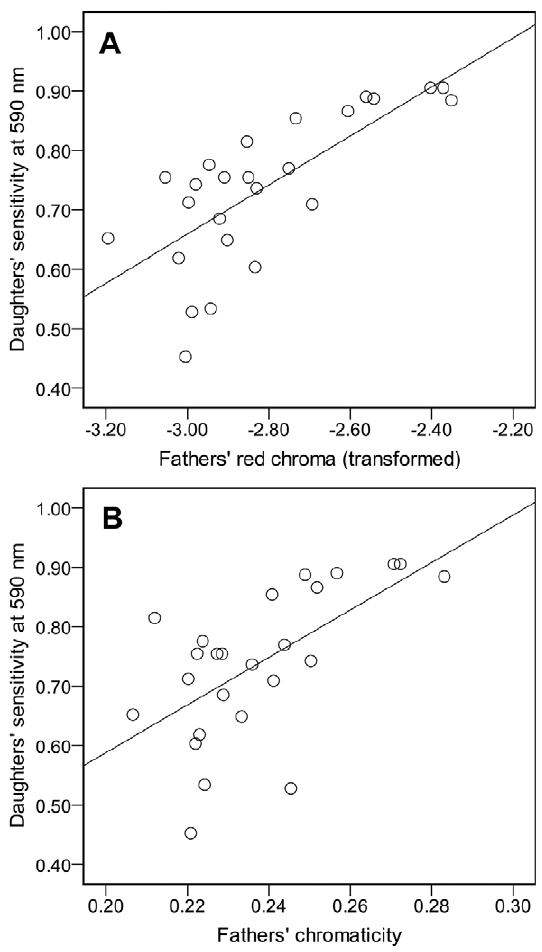
Figure 2. Spectral data on male red coloration and female red sensitivity. (A) Spectral reflectance for the cheek region of 25 reproductively active males. Plotted is the mean of the reflectance intensities (black line) 6 standard deviation of the mean (shaded area). Reflectance was measured relative to a 98% white reference standard. (B) Mean relative sensitivity of daughters at three wavelengths of long- wave light (590, 610 and 630 nm) as measured in optomotor response tests. Error bars indicate standard deviation of the mean.